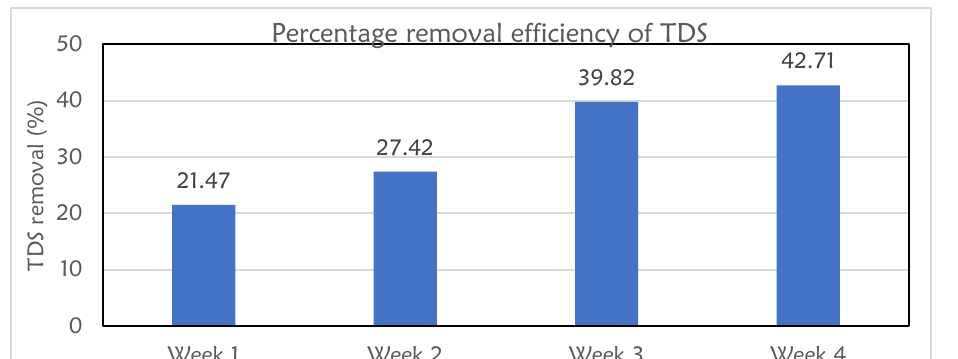
Figure 3: Percentage removal efficiency of TDS analysis of 4 weeks.